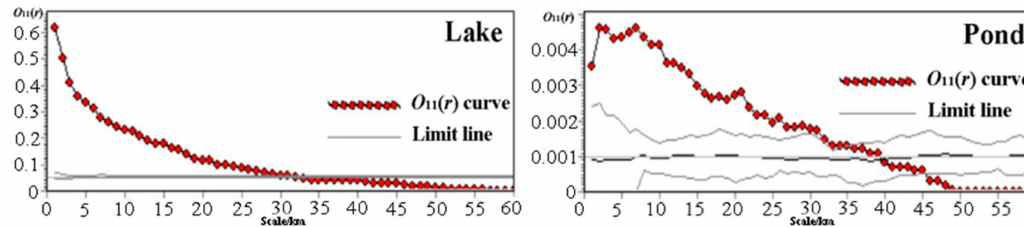
Figure 14. Horizontal distribution pattern function varies with spatial